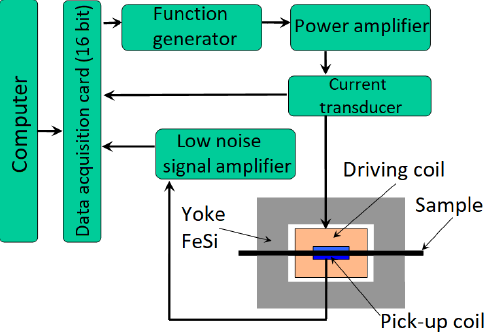
Figure 5. Set-up of the AC magnetometer.